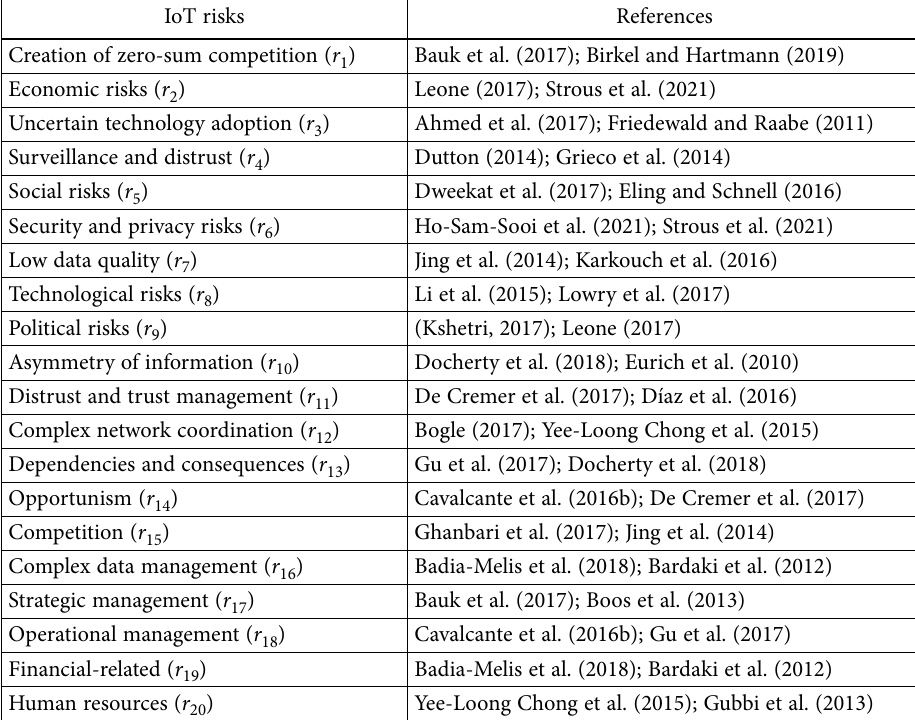
Table 1. Considered IoT risks for SCM IoT